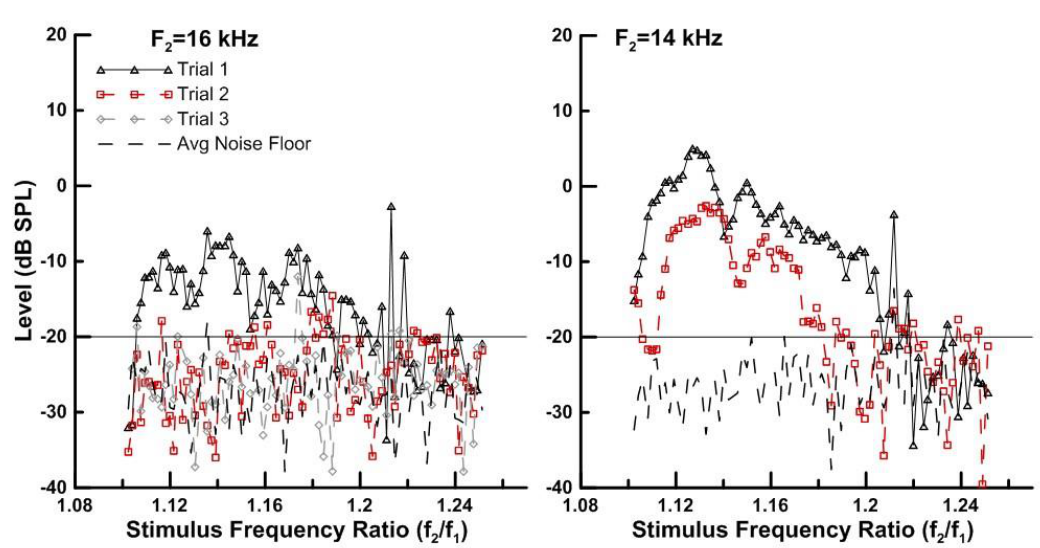
Figure 3. Ratio sweep data (f 2 / f 1 = 1.1–1.25 (0.002 steps), L 1 / L 2 = 62 / 52 dB FPL) for patient 9 at the highest ( left panel ) and second highest ( right panel ) frequency with a present DPOAE from the gross sweep. Black triangles, red squares, and grey diamonds indicate session 1, 2, and 3, respectively. The thin dashed black line indicates the average noise floor for all three sessions. Sessions and trials are synonymous.